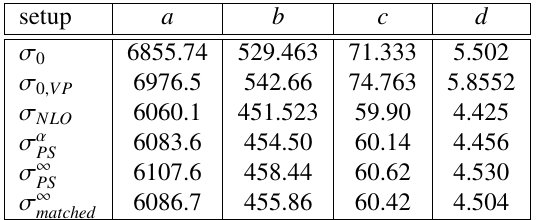
Table 1. Bhabha cross section (in nb) according to di ff erent precision levels. The table is taken from the second paper in Ref. [2], where also the experimental setups are